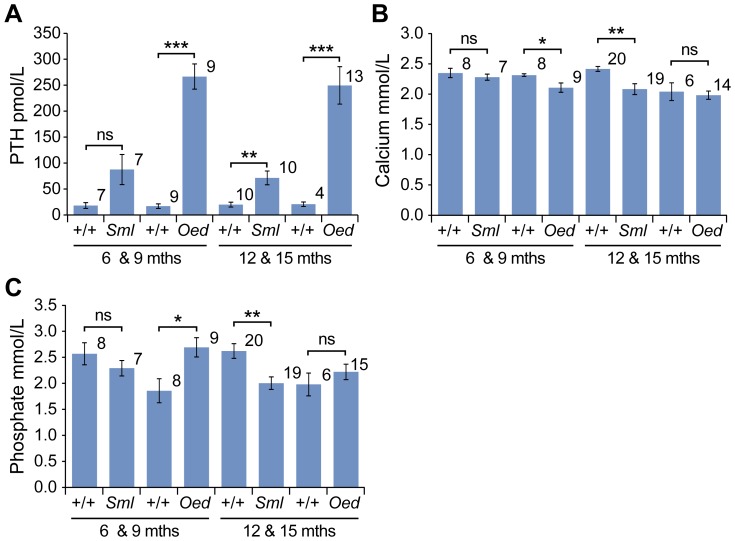
Plasma biochemistry phenotypes of male Sml and Oed mice.(A) Plasma PTH was significantly elevated in Oed mice at 6 & 9 and 12 & 15 months of age compared to +/+ controls. The modest elevation in Sml PTH levels at 6 & 9 months failed to reach significance (P = 0.053) but PTH was significantly elevated at 12 & 15 months compared with respective +/+ controls. Plasma calcium corrected for albumin levels (B) in Oed mice was lower than their respective +/+ controls at 6 & 9 months but not at 12 & 15 months. Calcium in Sml males was not lower than in their respective +/+ controls at 6 & 9 months but was lower than controls at 12 & 15 months. Plasma phosphate levels (C) in Oed mice were higher compared with their respective +/+ controls at 6 & 9 months but not at 12 & 15 months. Plasma phosphate in Sml males was not significantly different from +/+ controls at 6 & 9 months and at 12 & 15 months was lower than +/+ controls. The group size n is indicated alongside each histogram bar, the error bar is ± s.e.m; ns = not significant P>0.05, *P<0.05, **P<0.01, ***P<0.001. 2-tailed t-tests with unequal group variance were performed on the PTH data.